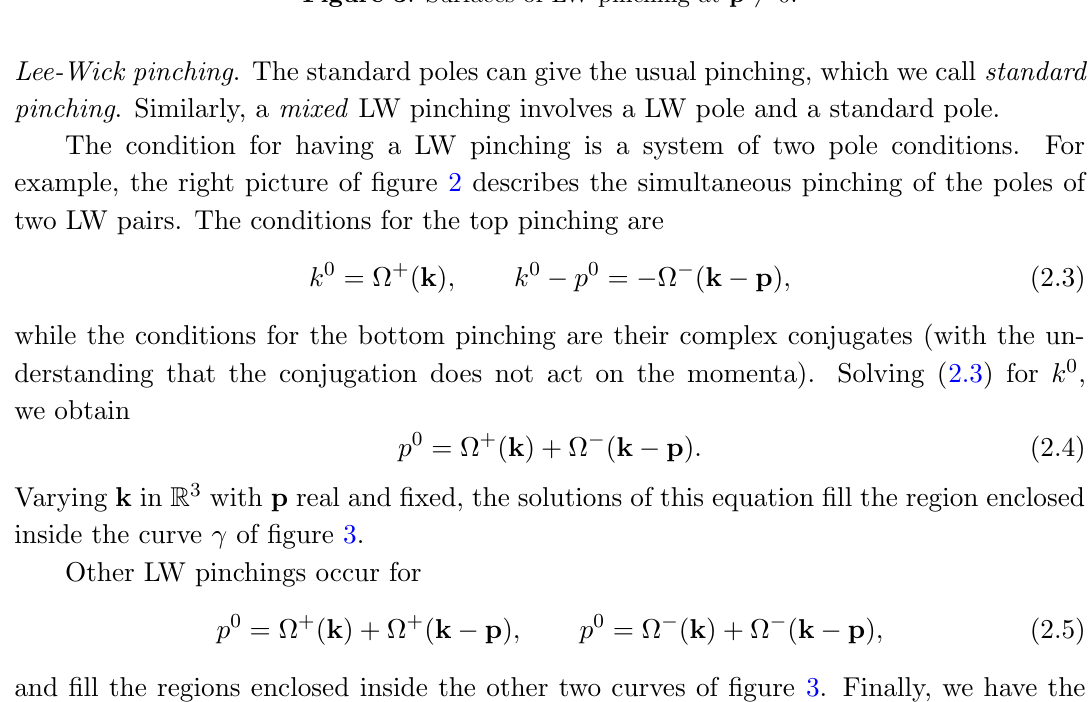
Figure 3 . Surfaces of LW pinching at p